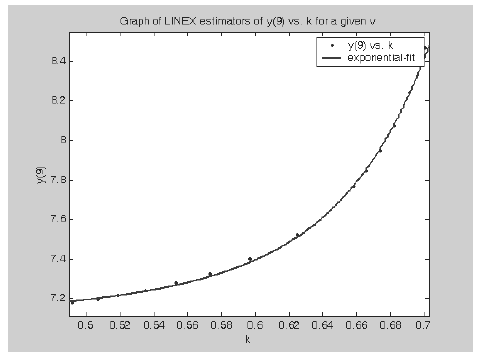
Figure 6 – Graph of LINEX estimators of (9) y vs. k for a given v .